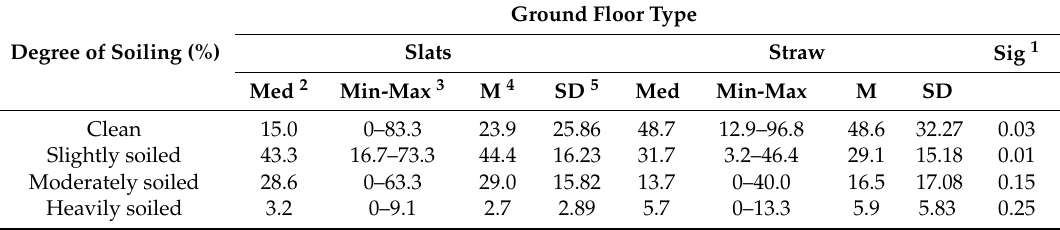
Table 2. Degree of soiling (measured in percentage of rabbits per pen being clean, slightly, moderately, or heavily soiled) in pens with the ground floor consisting of slatted plastic panels (Slats, n = 12) or pens with the ground floor consisting of concrete littered with straw (Straw, n = 12) at the age of 82 days. Ground Floor Type Degree of Soiling (%) Slats Clean Slightly soiled Moderately